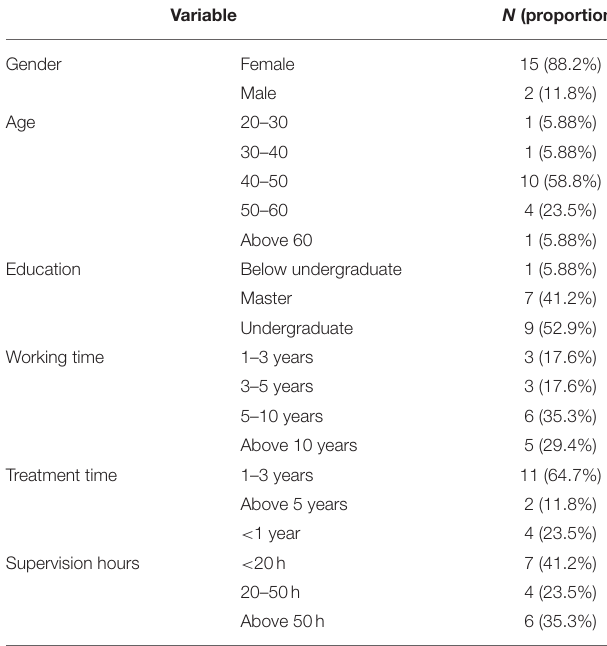
TABLE 1 | Summary descriptives table for clients ( n = 107). TABLE 2 | Summary descriptives table for psychological consultant ( n =